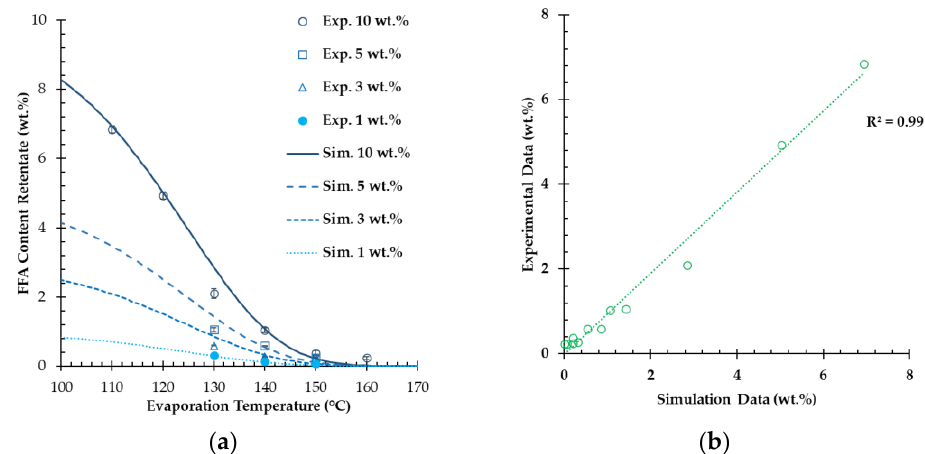
Figure 6. ( a ) Comparison of experimental and simulated FFA contents in retentate against evaporation temperature (FFA contents in feed: 1, 3, 5, or 10 wt.%). ( b ) Experimental FFA content data in retentate plotted against simulation data.